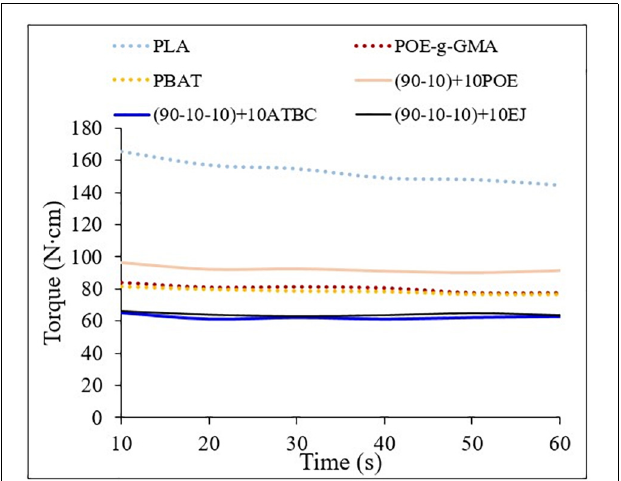
FIGURE 6 | Mechanical properties for plasticized ternary blends: (A) Elastic Modulus; (B) Elongation at break; (C) Charpy Impact